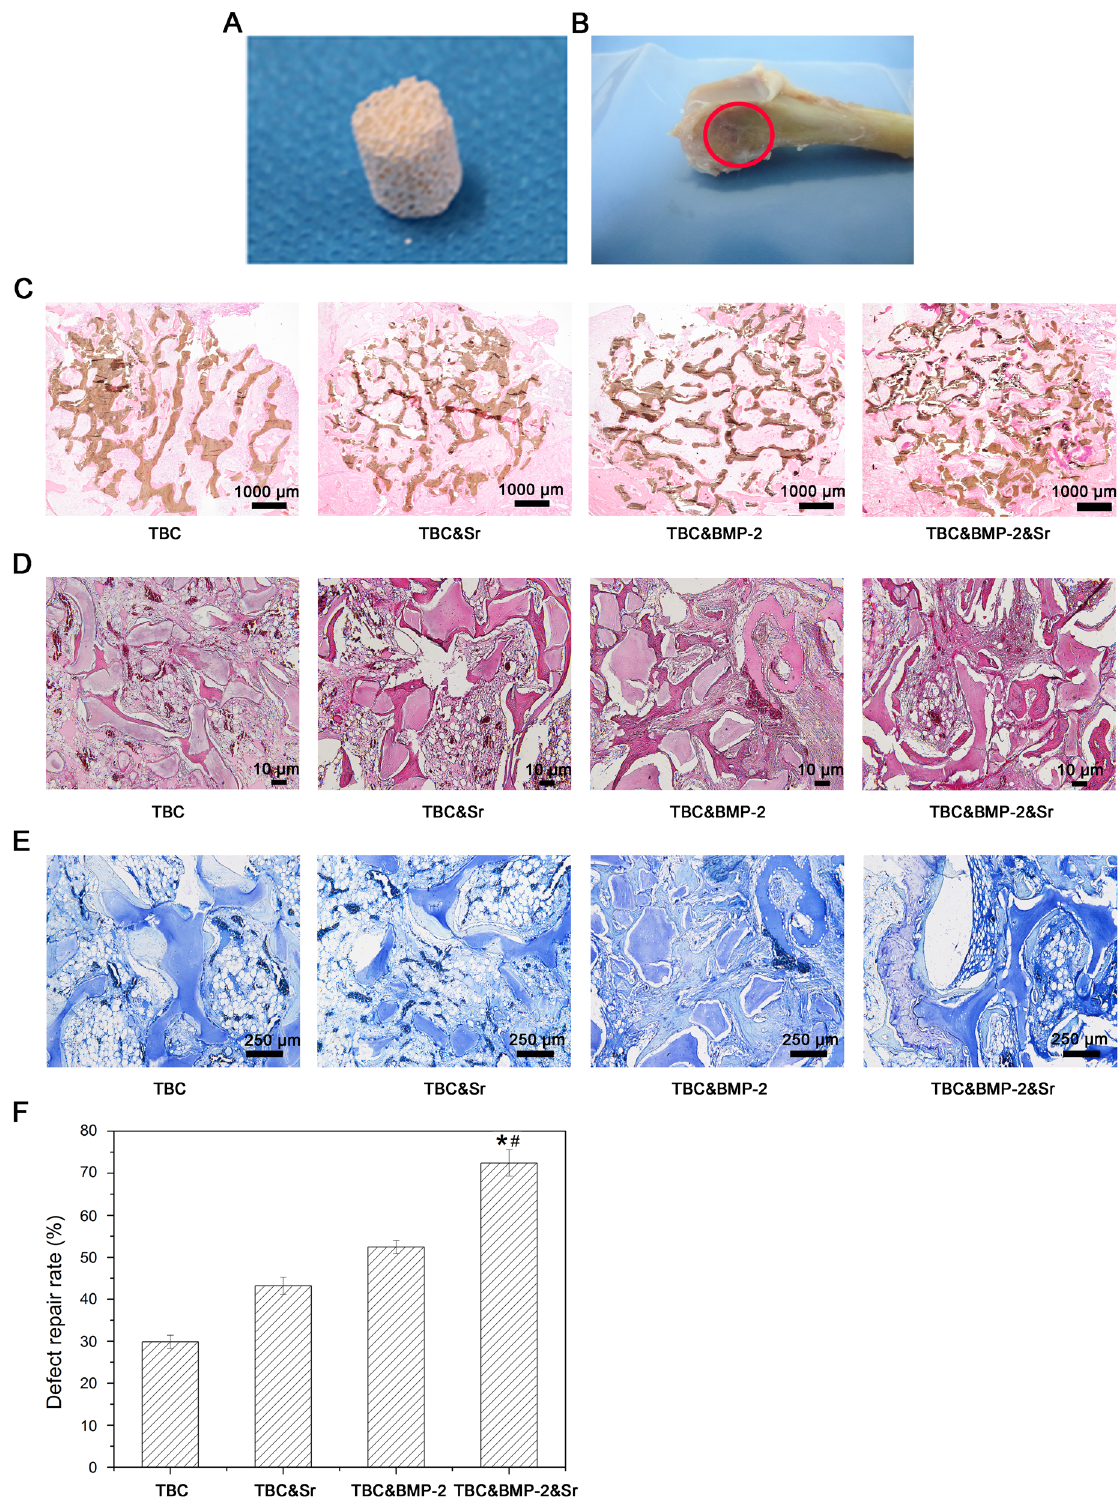
Fig. 3 Rabbit femoral condyle bone repair experiment. A The appearance of experimental material; B The repaired bone 6 weeks after the surgery; C Hard tissue section (HE staining, 40×); D Paraf fi n